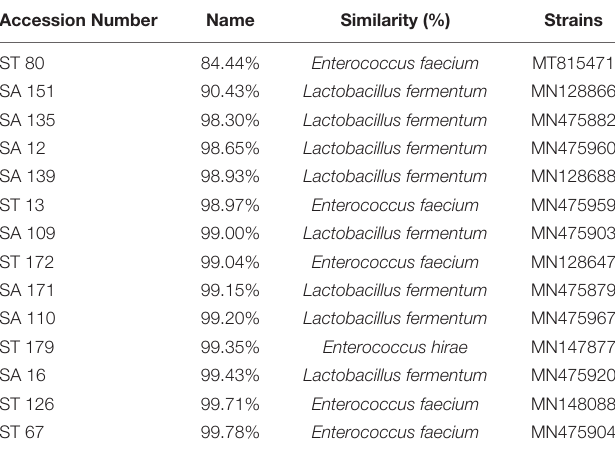
TABLE 6 | Candidate probiotics identified based on percentage similarity of the 16s rRNA sequence to those available in the GenBank database.